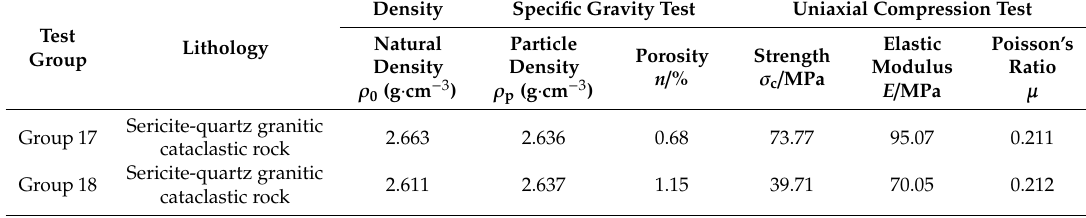
Table 1. Result of laboratory testing.